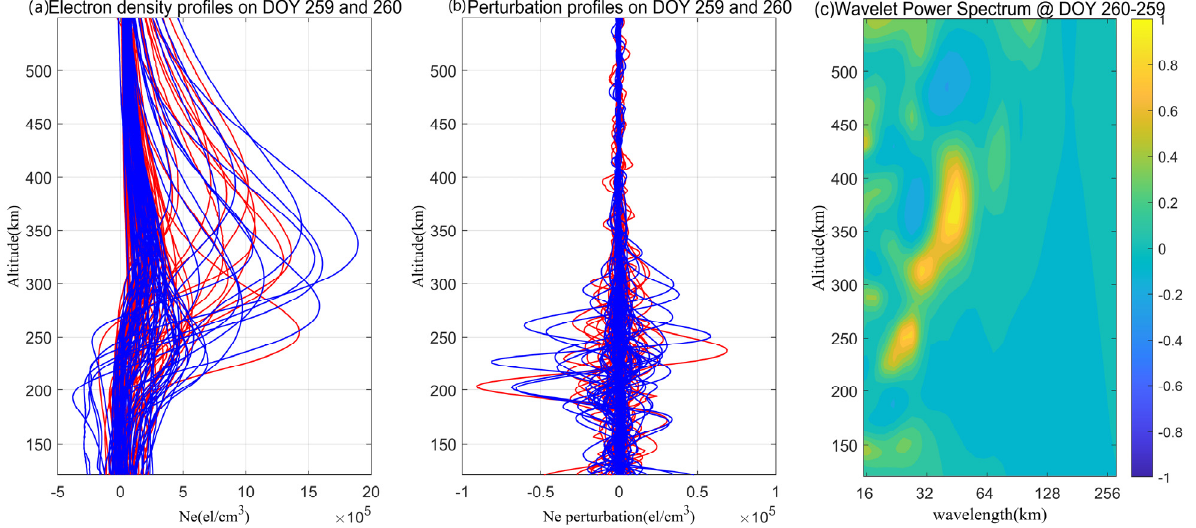
Figure 5. ( a ) Electron density profiles detected by the F3/C ionPrf datasets on DOY 259 (blue) and 260 (red) of 2015. ( b ) The corresponding electron density perturbation profiles. ( c ) The corresponding wavelet power spectrum differences between DOY 259 and 260 of 2015.